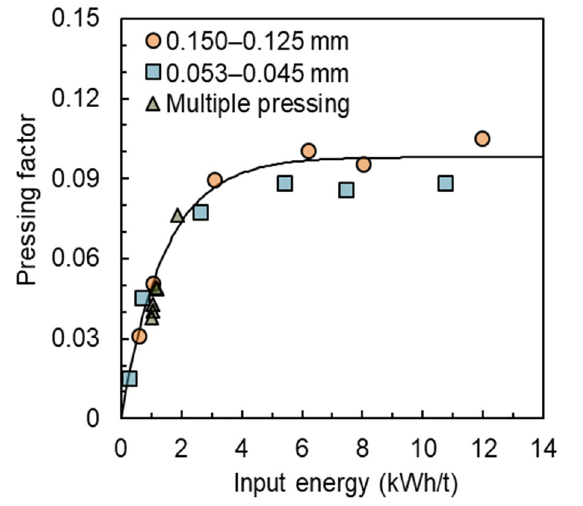
Figure 11. Relationship between the factor κ and specific input energy for the Itabira sample, including data for single and multiple pressings (106–75 µm).